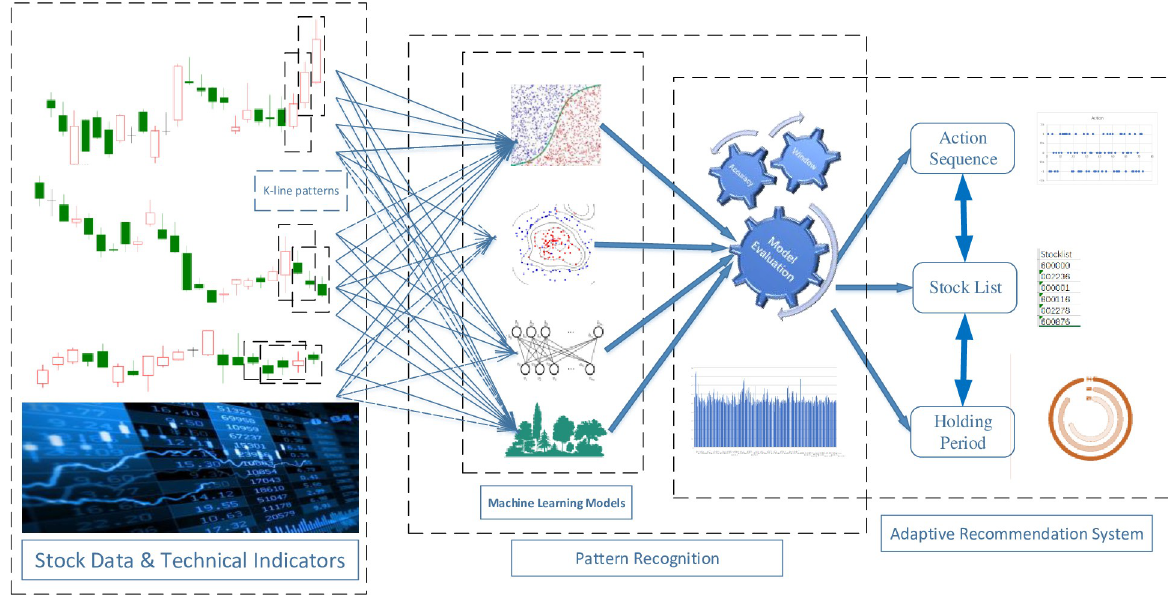
Fig 1. Overview of the PRML